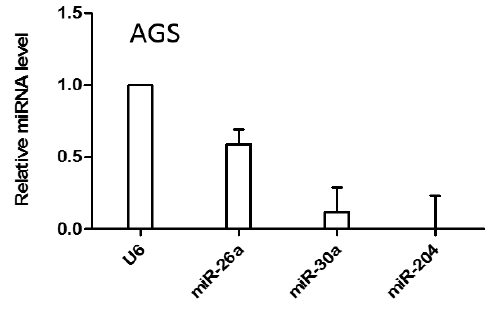
Figure 3. Relative miRNA expression in the AGS cell line. miRNA expression level was normalized to U6 miRNA and calculated from the triplicates data. Table 2. Down-regulated miRNAs in at least three datasets.